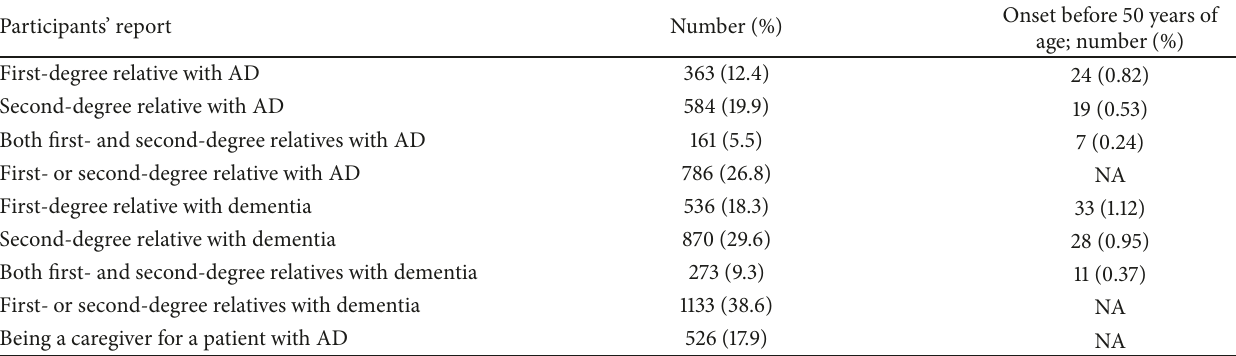
Table 2: Participants’ report of family history of Alzheimer’s disease, dementia, and age of onset before 50 years (total number of participants =2935).